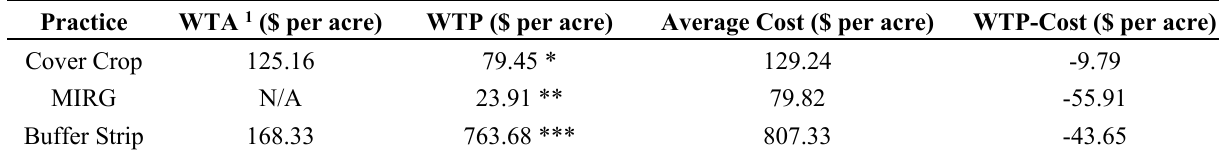
Table 2. Comparison of WTA, WTP, and Average Practice